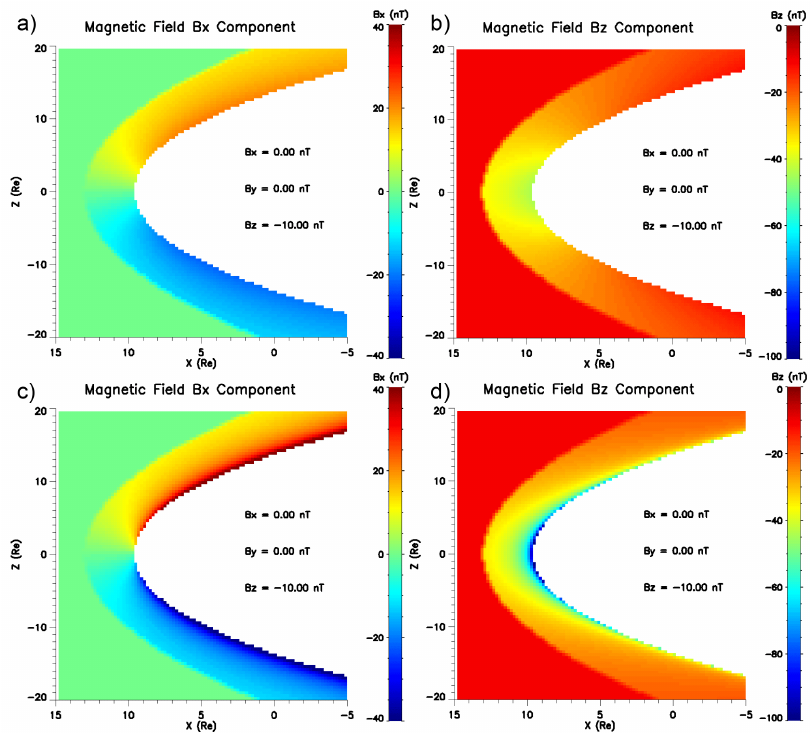
Fig. 3. Colour maps of the magnetosheath magnetic field (nT) – left panels: B x – right panels: B z – upper panels: Kobel and Flückiger (1994) analytic magnetic field model – lower panels: magnetic field propagated with MHD equations along the flowlines. The boundaries of the magnetosheath are calculated with the Kobel and Flückiger (1994) model. The B x , B y and B z indicated in each plot correspond to the upstream magnetic field